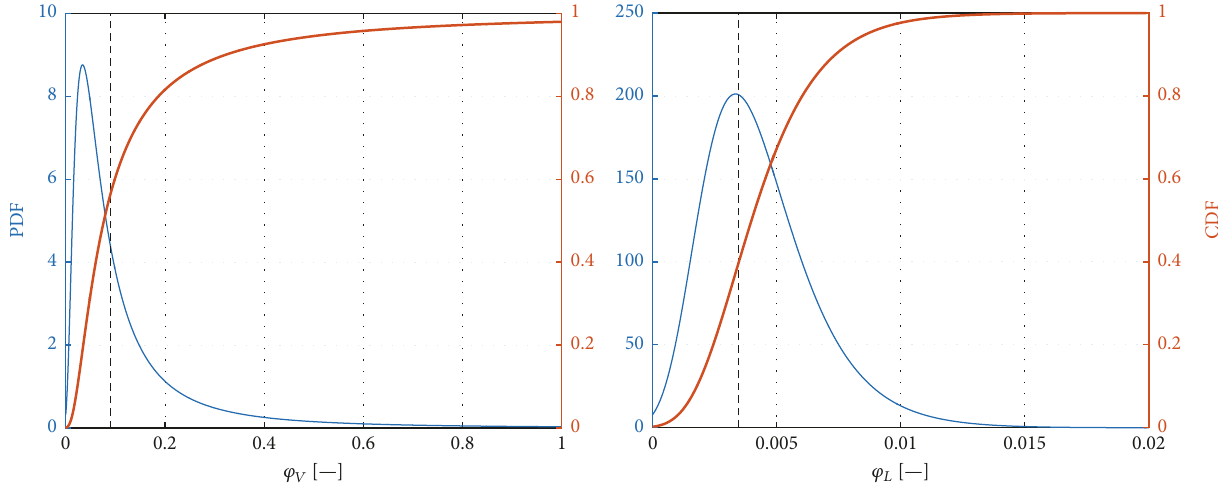
Figure 13: Probability Density Function (PDF, thin line) and Cumulated Distribution Function (CDF, thick line) of 𝜑 𝑖 for the vertical and lateral direction (GEV parameters are reported in (38)). The vertical dashed line indicates the deterministic acceleration demand TFRFs, 𝐷 𝑉 and 𝐷 𝐿 (see